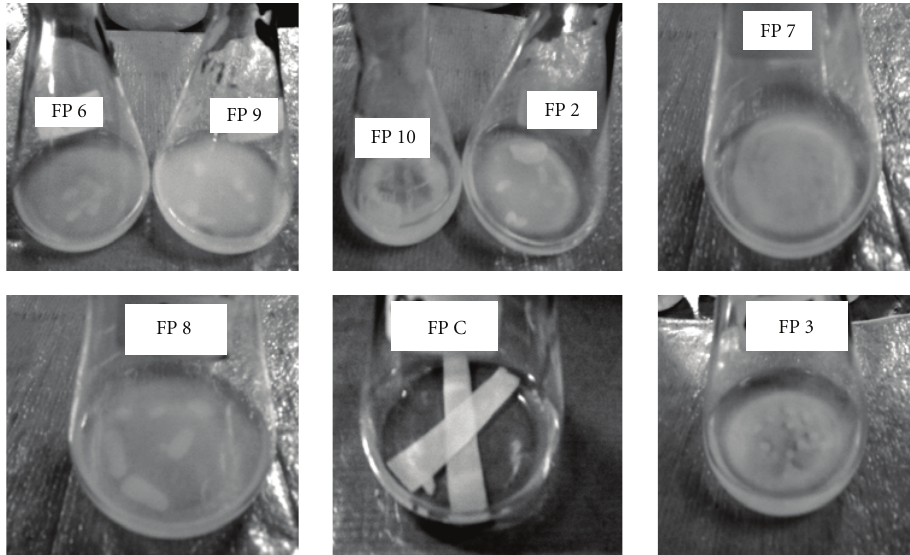
Figure 3: Filter paper degradation by isolates CDB 2, 3, 6, 7, 8, 9, and 10 cultured in basal salt medium supplemented with Whatman filter paper no.1 (1 × 6 cm strip × 2, 0.05 g per 20 mL) at the end of 96 hrs of incubation. Flask FP C is the control for this experimental set up and does not show any filter paper degradation.